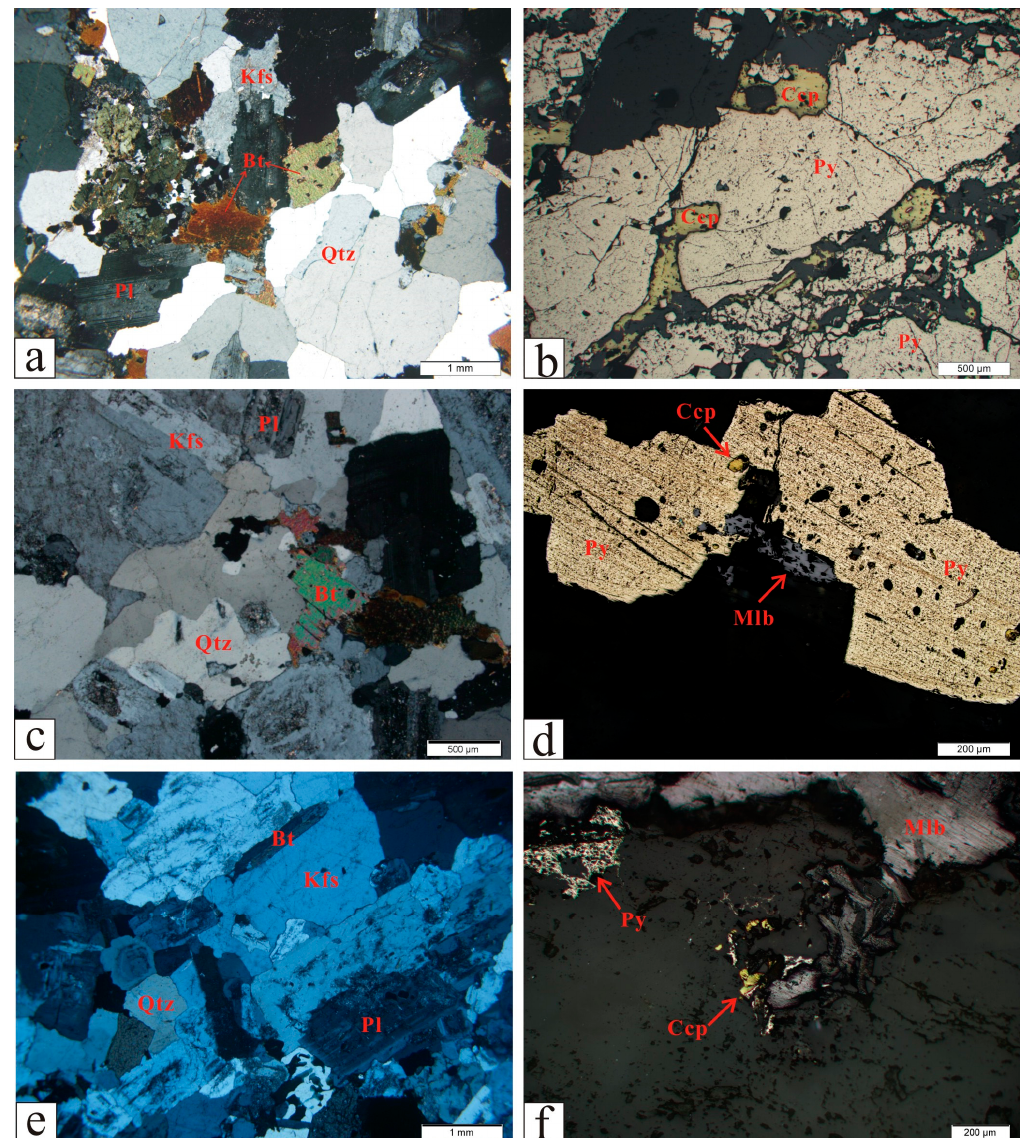
Figure 3. Photomicrographs of ore-hosting rock and microscopic mineralization characteristics of the Shulan Mo or Cu–Mo deposits: ( a ) adamellite and ( b ) chalcopyrite perforated pyrite from the Chang’anbu deposit; ( c ) granodiorite and ( d ) molybdenite perforated pyrite from the Fu’anbu deposit; ( e ) granodiorite and ( f ) molybdenite perforated chalcopyrite from the Jidetun deposit. Kfs = K-feldspar; Bt = biotite; Pl = plagioclase; Qtz = quartz; Ccp = chalcopyrite; Py = pyrite; Mlb = molybdenite).